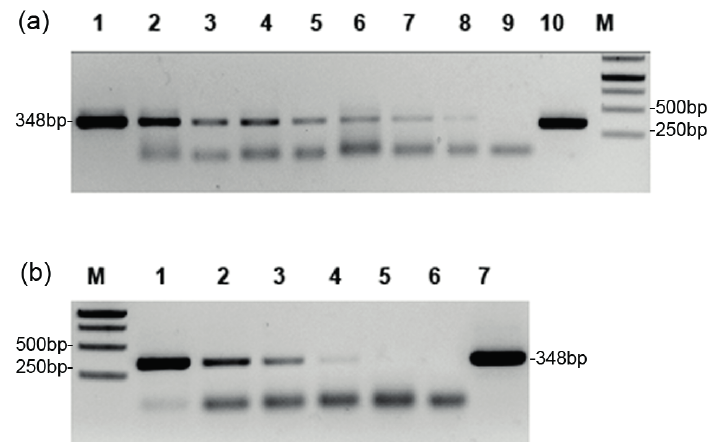
Fig. 1. Sensitivity of the Rc3/Rc5 primer set on Rcc strain RCC2. (a) 10-fold serial dilutions of purified Rcc . Lanes: 1. 50 ng; 2. 5 ng; 3. 0.5 ng; 4. 50 pg; 5. 5 pg; 6. 0.5 pg; 7. 0.05 pg; 8. 0.005 pg; 9. negative control (SDW); 10. positive control (100 pg of Rcc DNA); M. 1.0 kbp DNA ladder Plus (Thermo Scientific). (b) Spiking 100 ng of barley DNA with varying amounts of Rcc DNA: Lanes: 1. 5 ng; 2. 50 pg; 3. 0.5 pg; 4. 0.005 pg; 5. 0.00005 pg; 6. negative control (SDW); 7. positive control (100 pg of Rcc